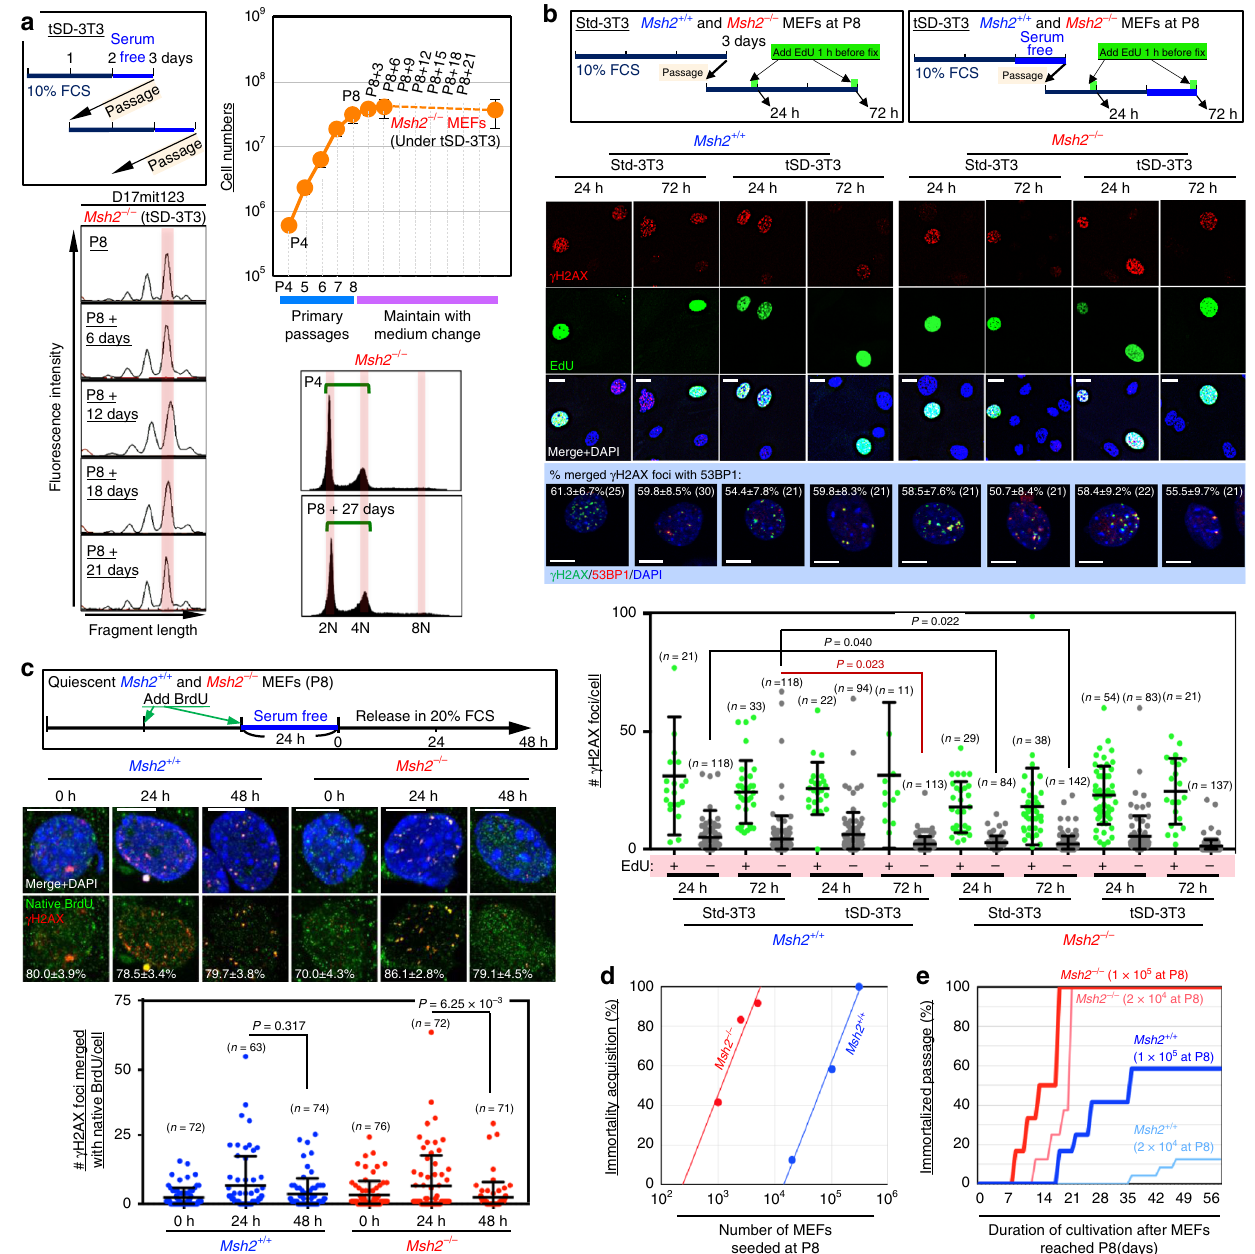
Fig. 2 Replication stress is associated with MSI induction in MMR-de fi cient cells. a Msh2 − / − MEFs were cultivated under the tSD-3T3 protocol, and the effects on immortalization and the MSI status were monitored. The graph shows mean cell numbers ± s.d. ( n = 3 independent experiments with MEFs prepared from independent fetuses). b Msh2 + / + and Msh2 − / − MEFs were treated as shown in the work fl ows. γ H2AX foci were detected by immuno fl uorescence with or without EdU staining. γ H2AX and 53BP1 were detected by immuno fl uorescence ( n numbers are indicated in graph). Percentages of γ H2AX foci merged with 53BP1 foci (means ± s.e.) are indicated in each image. Bars show means ± s.d. Scale bars, 10 μ m. Two-tailed Welch ’ s t -test was used for statistical analysis. c , Msh2 + / + and Msh2 − / − MEFs were treated as shown in the work fl ow. Foci of γ H2AX and BrdU under native conditions were detected by immuno fl uorescence ( n numbers are indicated in graph). Percentages of γ H2AX foci merged with native BrdU foci (means ± s.e.) are indicated in each image. Bars show means ± s.d. Scale bars, 10 μ m. Two-tailed Welch ’ s t -test was used for statistical analysis. d , e Multiple subcultures of Msh2 + / + and Msh2 − / − MEFs (P8) were seeded at the indicated cell numbers. The frequency ( d ) and speed ( e ) of immortalization were